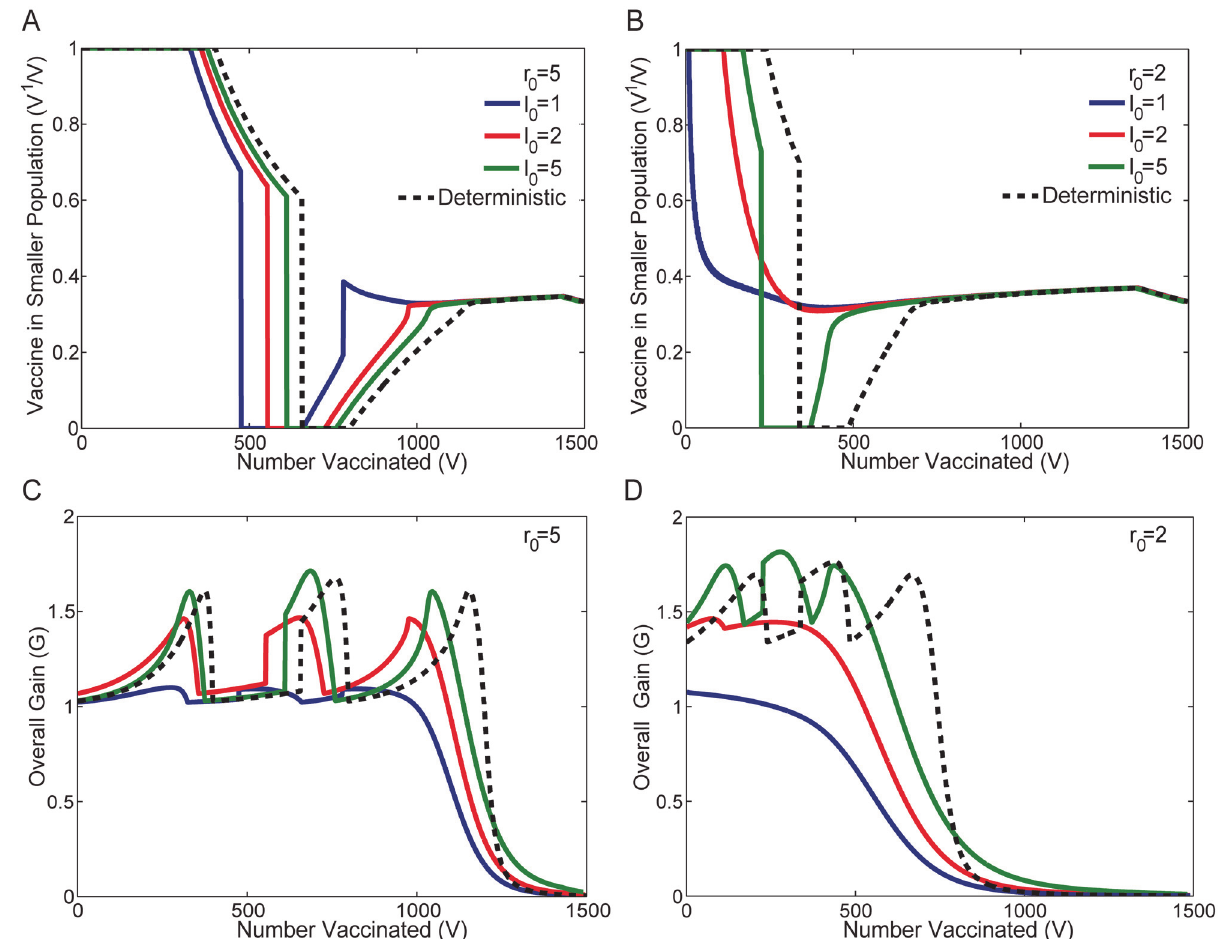
Fig 6. Variation of the Optimal Allocation with Increasing Likelihood of a Large-Scale Epidemic. The solid lines in Figures A and B illustrate the optimal fraction of the available vaccine allocated to the smaller population V 1 / V in order to minimize the average stochastic epidemic size h E i for varying values of I ¼ I 1 ¼ I 2 . The dashed black line shows the optimal allocation that minimizes the deterministic epidemic size E . Figures C and D illustrate the corresponding 0 0 0 overall gain G as a function of the total vaccine V for each of the curves in Figures A and B. The results are obtained for r 0 = 5 in Figures A and C, and r 0 = 2 in Figures B and D, and populations of sizes N 1 = 500 individuals and N 2 = 1000 individuals. As the initial seed population of infected individuals is increased, ¼ I 2 ¼ 1 (as in Fig. 4), to I 1 ¼ I 2 ¼ 5, both populations are increasingly likely to experience a large-scale epidemic. Specifically, in the stochastic from I 1 0 0 0 0 model, the probability of having large-scale epidemics in both populations for I 0 = 1, 2, 5 is, respectively, 0.6392 (blue), 0.9210 (red), and 0.9993 (green) for r r 0 = 5 and 0.2468, 0.5559, and 0.9334 for 0 = 2. While both the optimal allocation and gain in the stochastic model becomes more similar to the deterministic limit with increasing I 0 , it does not converge to the deterministic limit for finite r 0 due to the non-negligible width of the distribution of large-scale epidemics that is observed in the stochastic